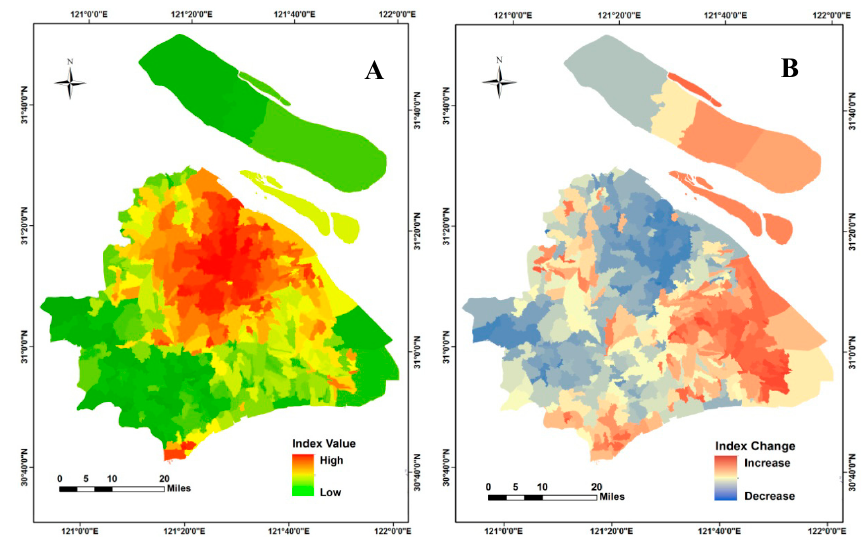
Figure 3. The I URB and its changes between 2007 and 2015. ( A ) The 2015 Urban Index ( I URB ). ( B ) The 2007–2015 Urban Index Change.